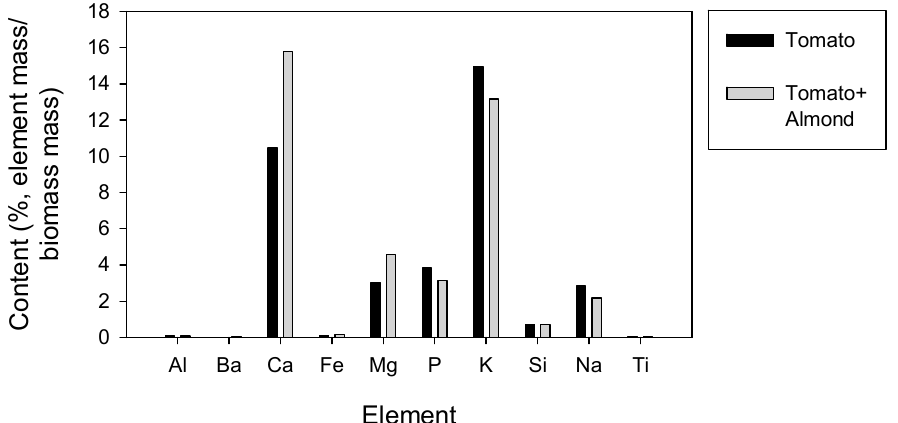
Figure 2. Elemental composition of the tomato-crop biomass, and the blend of this with almond